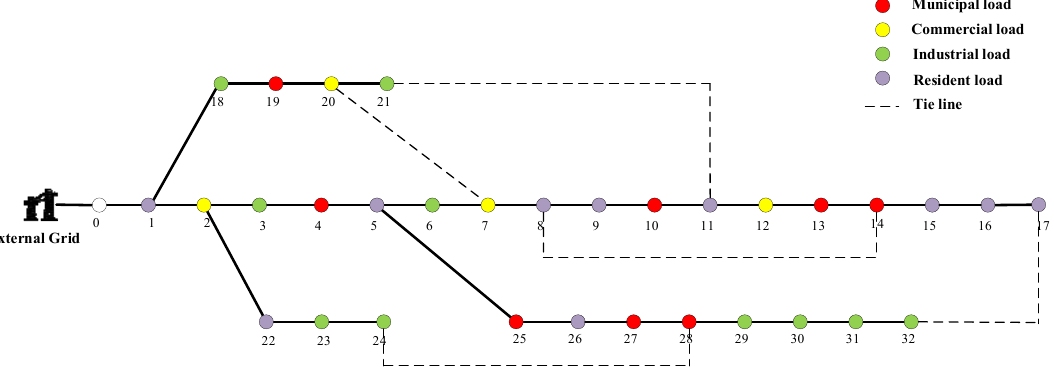
Figure 4. IEEE 33 Distribution Network.